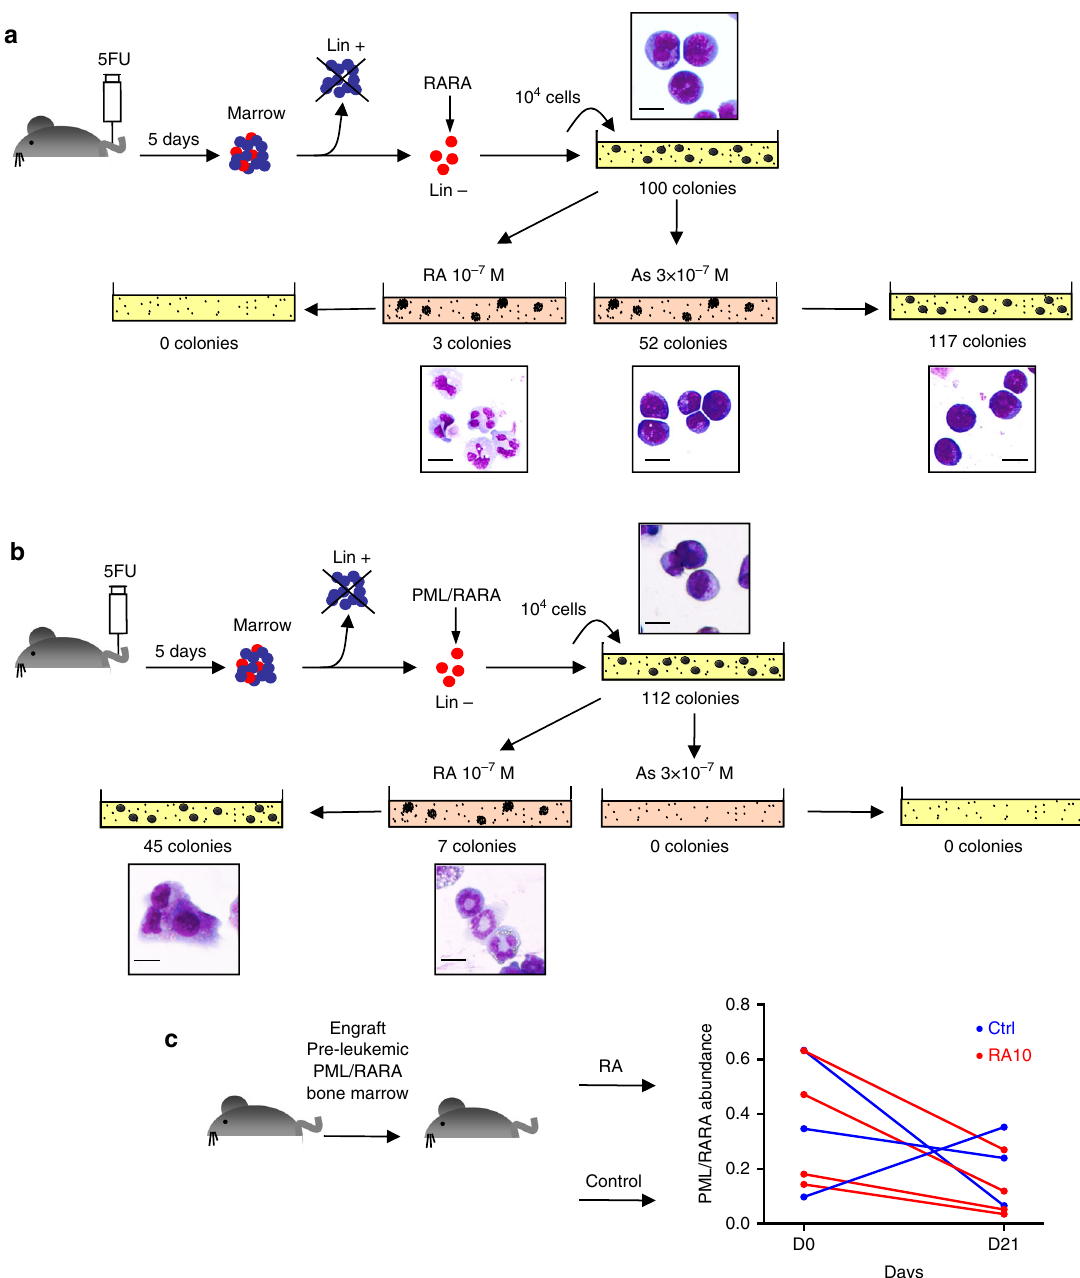
Fig. 3 Effect of therapies on self-renewal of RARA- or PML/RARA -transformed progenitors. a Mouse primary progenitors were immortalized by RARA overexpression and propagated in methylcellulose cultures with the indicated treatments. Treated cells were then regrown without further drug exposure. Colony numbers and MGG stains are shown. Scale bar: 10 μ m. b Same as above with PML/RARA -transformed progenitors. Representative experiment of three independent replicates. c Effect of RA therapy on the abundance of pre-leukemic PML/RARA -expressing cells in vivo. Relative PML/RARA DNA abundance, as determined by qPCR comparing PML/RARA and CEBPA abundance, is indicated for each mouse before and after therapy. Treatment did not result in signi fi cant difference in PML/RARA abundance, as demonstrated by paired Student's t -test The mouse images in this fi gure were drawn by Dr. Lehmann-Che for use in this